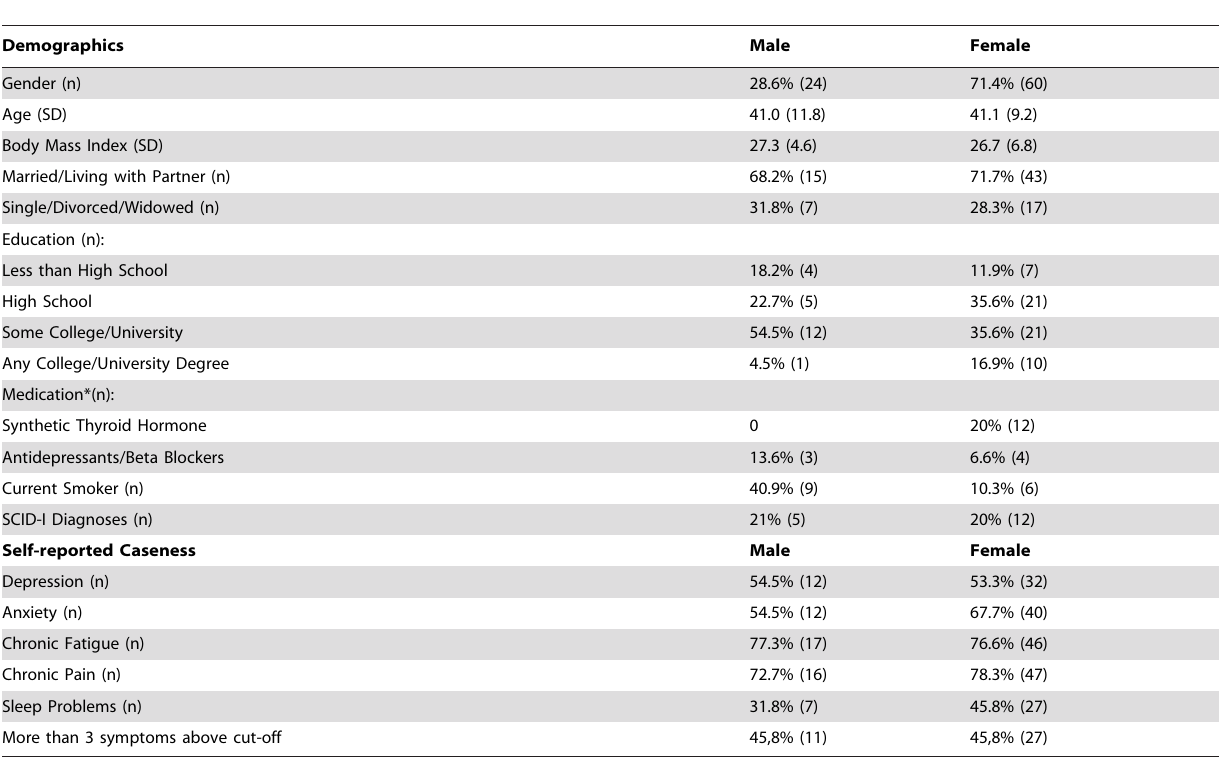
Table 1. Characteristics of participants (n =84) included in the Trier Social Stress Test for